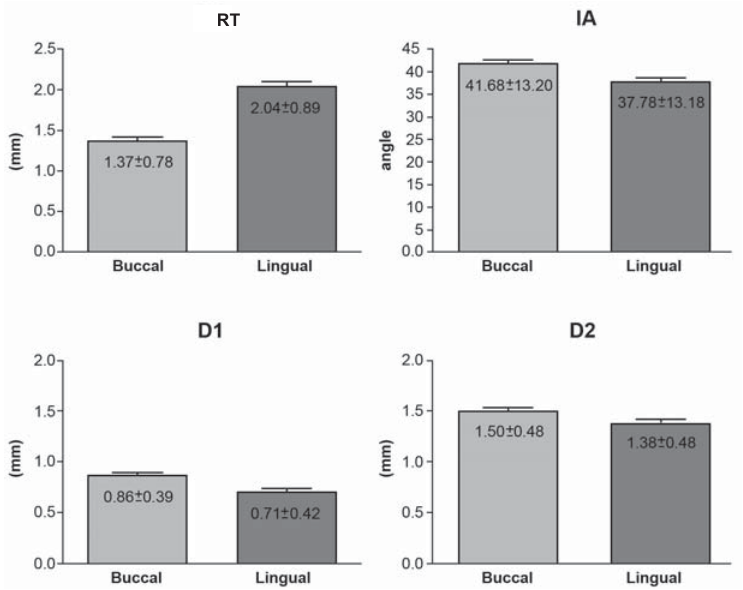
Figure 3- Mean and standard deviation (SD) values of root trunk height (RT), D1 and D2 linear measurements (mm)